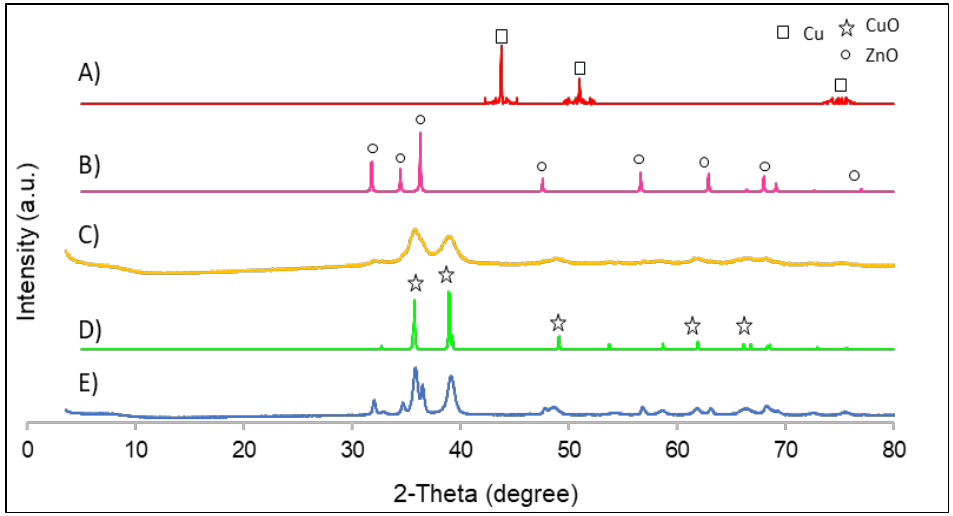
Figure 2. XRD patterns of all catalysts: ( A ) Cu nanoparticle simulation; ( B ) ZnO nanoparticle simu- lation; ( C ) Cu/ZnO nanoparticles; ( D ) CuO nanoparticle simulation; ( E ) CuO/ZnO nanoparticles.